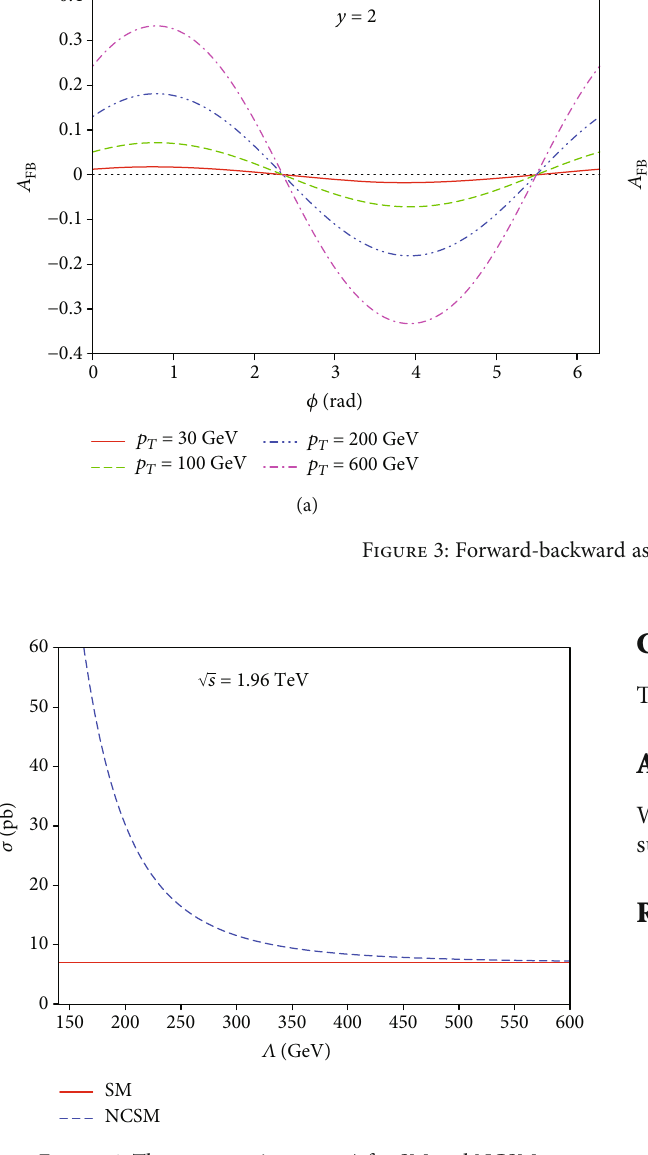
Figure 4: The cross-section σ vs. Λ for SM and